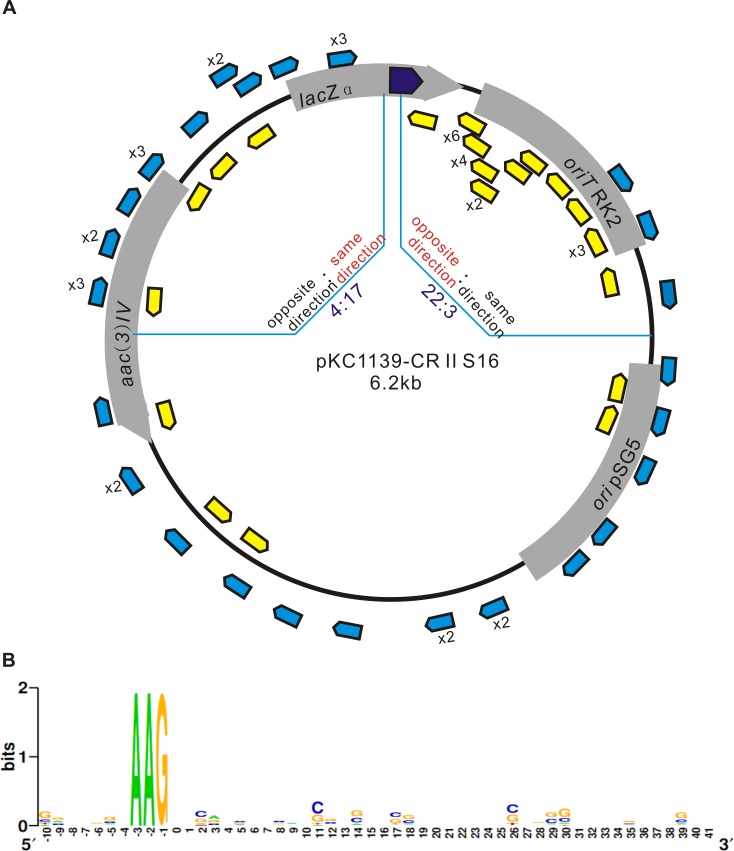
Orientation of protospacers and PAM motifs.(A) The dark blue arrow represents the location of the priming protospacer. Protospacers corresponding to acquired new spacers located on the plasmid DNA are indicated by blue arrows (protospacers derived from the same direction of the priming protospacer) and yellow arrows (protospacers derived from the opposite direction of the priming protospacer). Numbers next to arrows indicate the frequencies of identical spacers. The upstream and downstream regions near the priming protospacer are separated by light blue lines, and protospacers derived from two directions in the region are compared. (B) Ten nucleotides upstream and downstream of the protospacers were searched for PAM motifs using WebLogo. Position 0 represents the first nt of the protospacer.